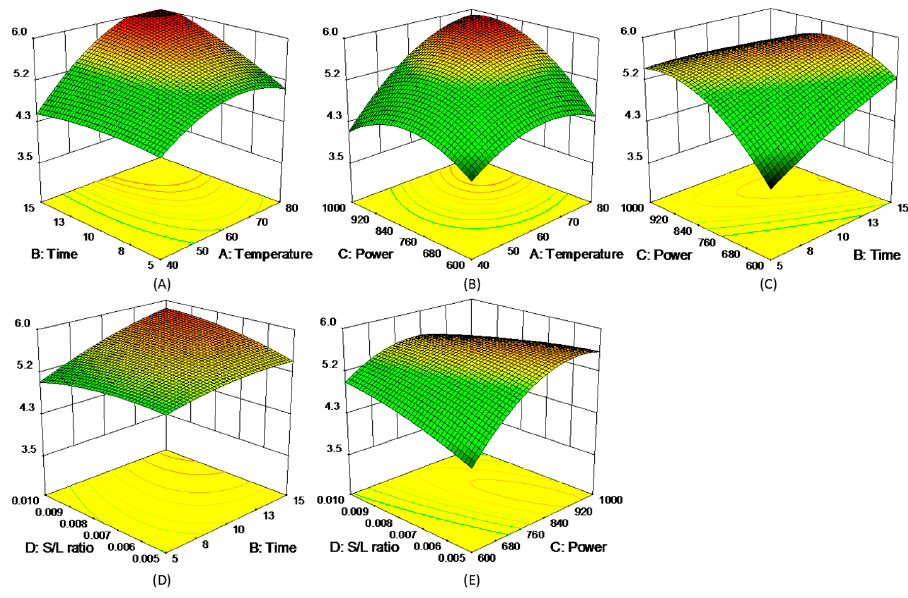
Figure 7. 3D response surface plots of T ІІ A.